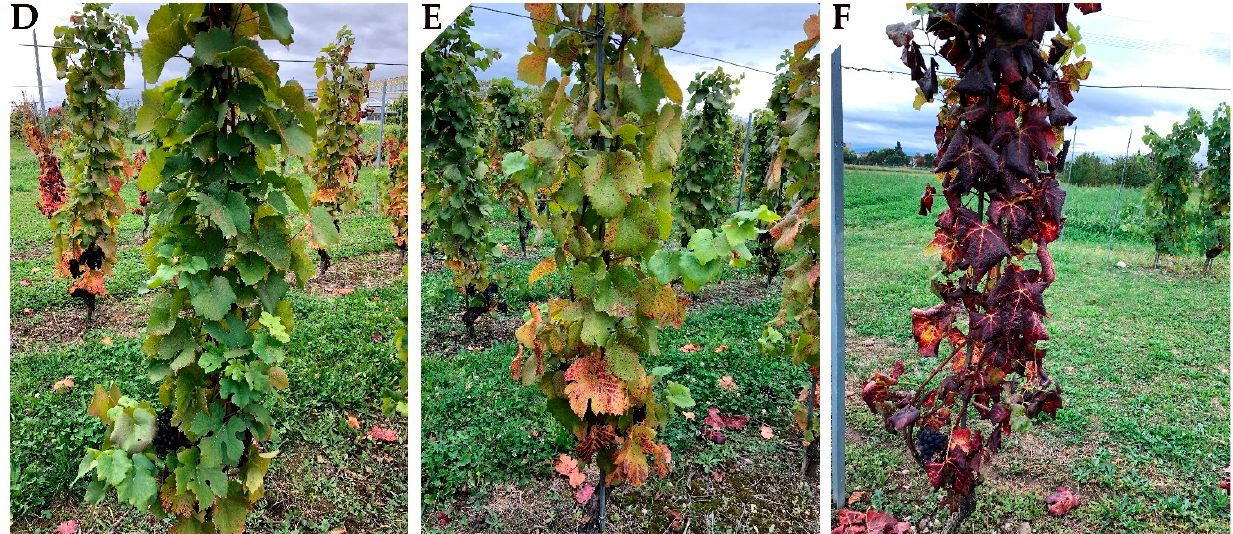
Figure 1. Symptomatology displayed on the three treatments of Vitis vinifera cv. Pinot noir on root- stock 5BB. Before veraison, early August ( A – C ) and at harvest in early October ( D – F ). Symptomless control with no leafroll symptoms ( A , D ); GLD_S+: grapevine leafroll disease causing mild symptoms ( B , E ); GLD_S++: grapevine leafroll disease causing severe symptoms ( C , F ). In 2018, sugar content and weight were assessed in single berries at the onset of veraison (when first visible signs of color change occurred). Sugar was significantly lower for the modality GLD_S++ when compared to the symptomless control or to GLD_S+. This sugar drop was not observed between GLD_S+ and the control (Figure 2).